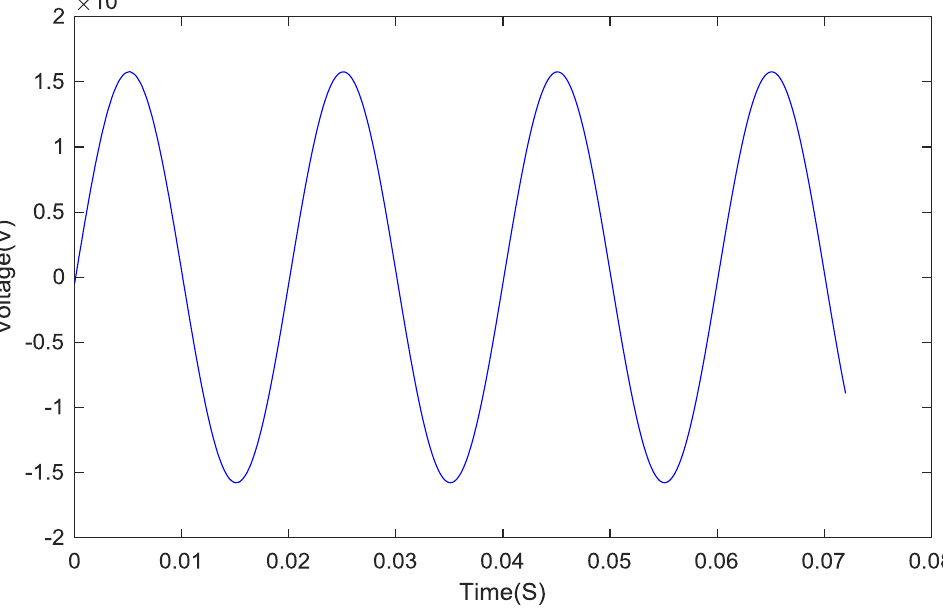
Figure 6. Voltage waveform of phase a in normal state.